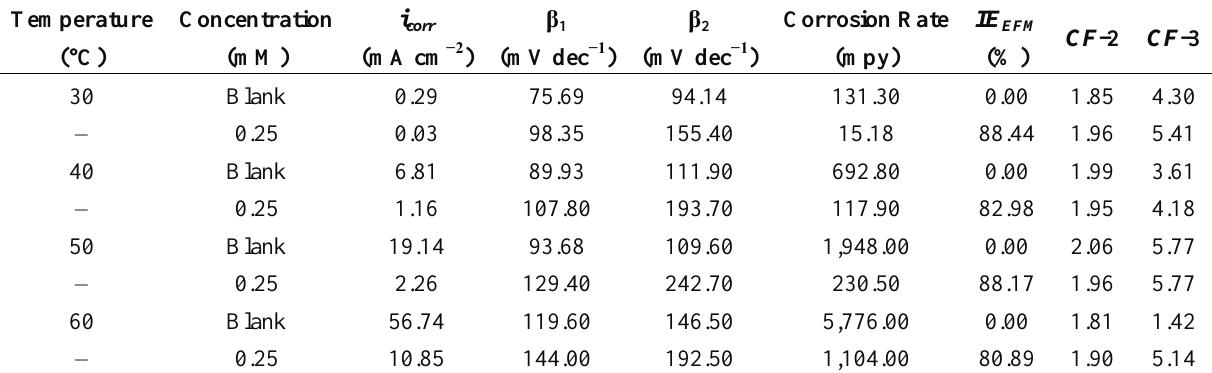
Table 7. EFM electrochemical parameters for mild steel in 1.0 M H the corrosion inhibitor at different